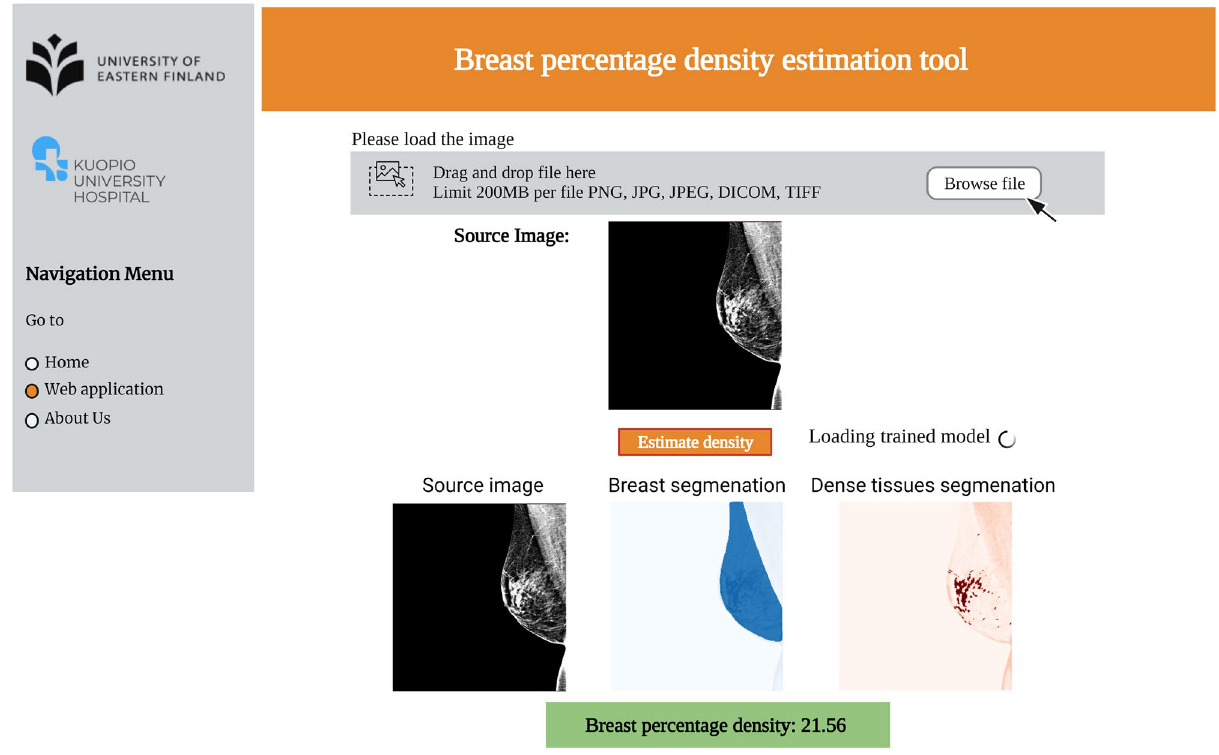
Figure 9. Sample website report of the MTLSegNet PD estimation